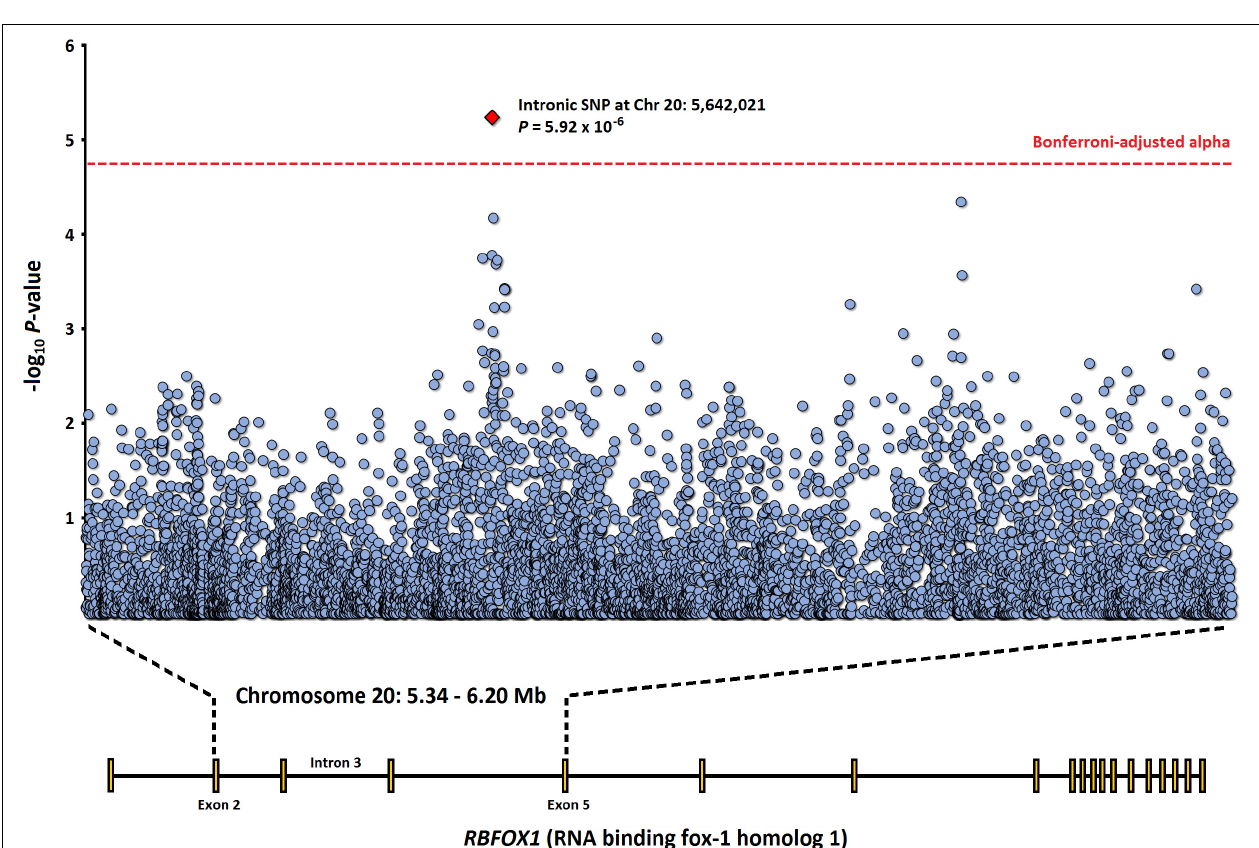
FIGURE 1 | Manhattan plot for part of RBFOX1 (chromosome 20: 5.34–6.20 Mb), covering exons 2, 3, 4 and 5, and introns 2, 3, and 4. The top SNP association result is shown as a red diamond.